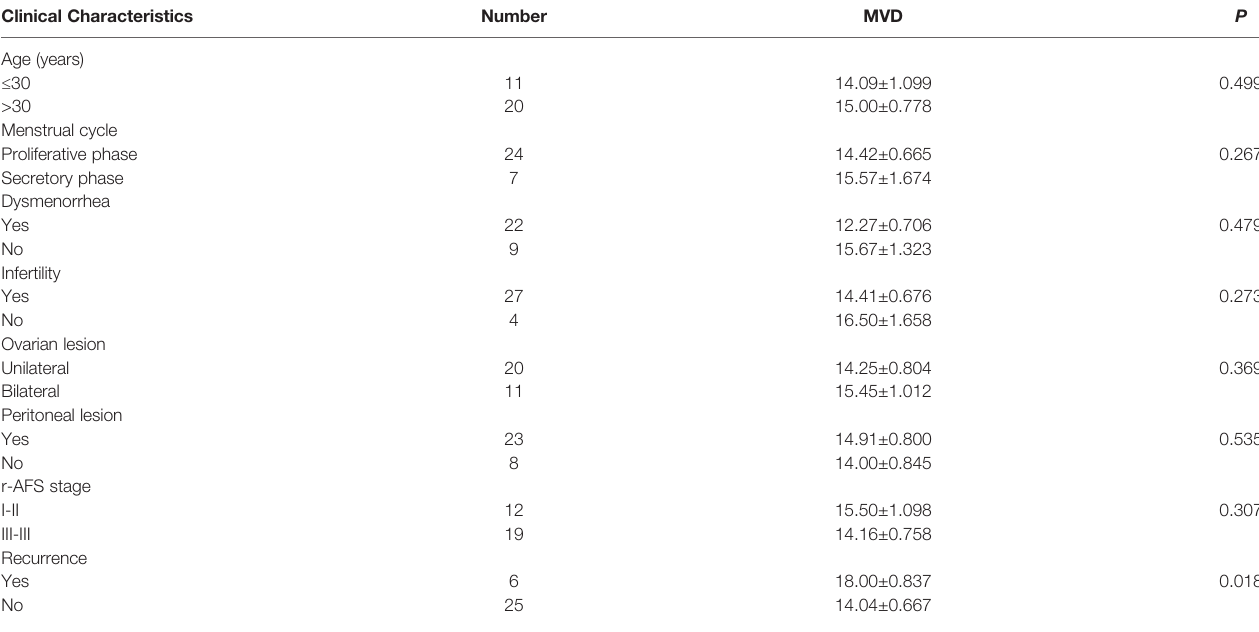
TABLE 2 | Correlations between MVD level in eutopic endometrium and clinical characteristics of EM patients. Clinical